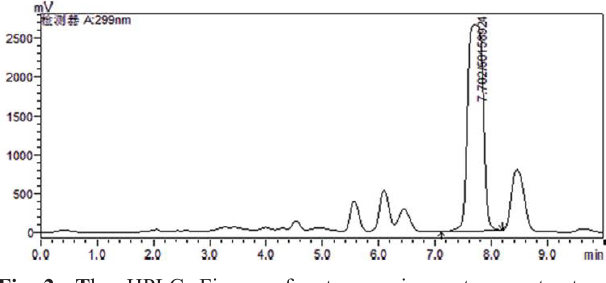
Fig 2. T he HPLC Figure of rotenone in acetone extract of Derris trifoliata roots.